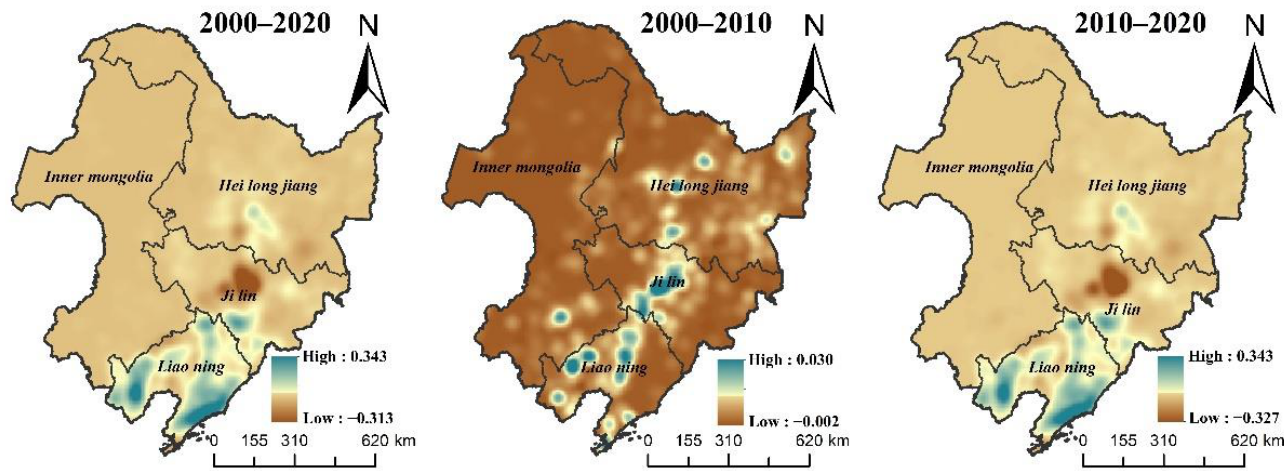
Figure 3. Variation of the nuclear density of rural settlements in Northeast China.